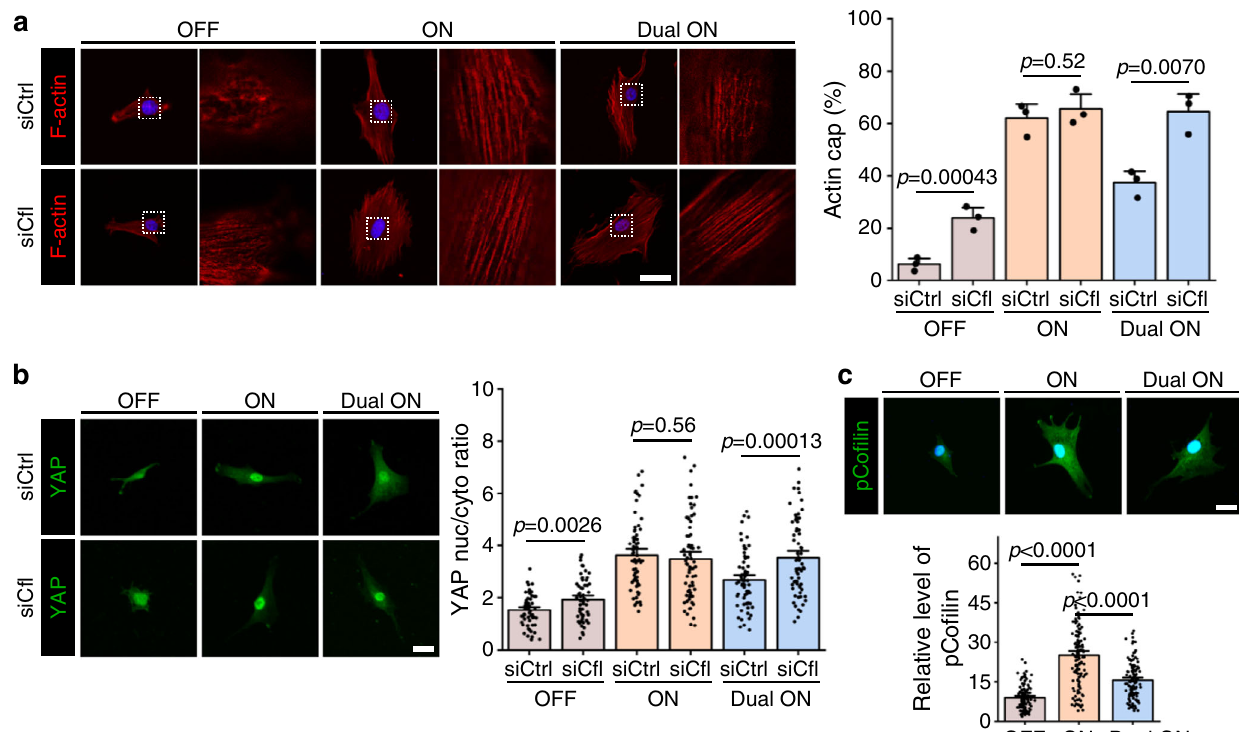
Fig. 6 | RGD/integrin and HAVDI/N-cadherin ligations affect hMSCs mechan- osensing by regulating co fi lin phosphorylation. a Left: Representative F-actin images in control and co fi lin-depleted hMSCs on “ OFF ” , “ ON ” and “ Dual ON ” sub- strates for 1 d. Zoomed regions display details of F-actin organization in the apical region of the nucleus. Right: Corresponding quanti fi cation of the percentages of hMSCs having an actin cap ( n = 3 experiments per group). b Left: Representative YAP images in control and co fi lin-depleted hMSCs on “ OFF ” , “ ON ” and “ Dual ON ”